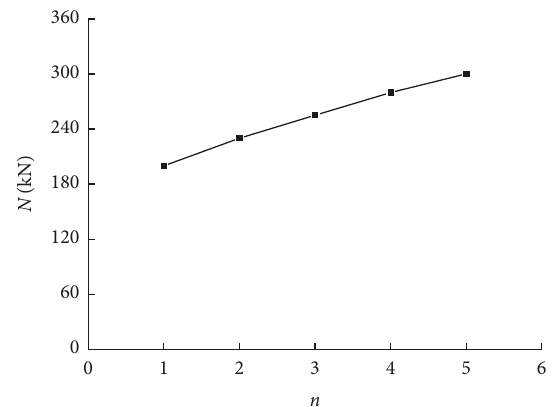
Figure 11: Influence of anchor plate number.